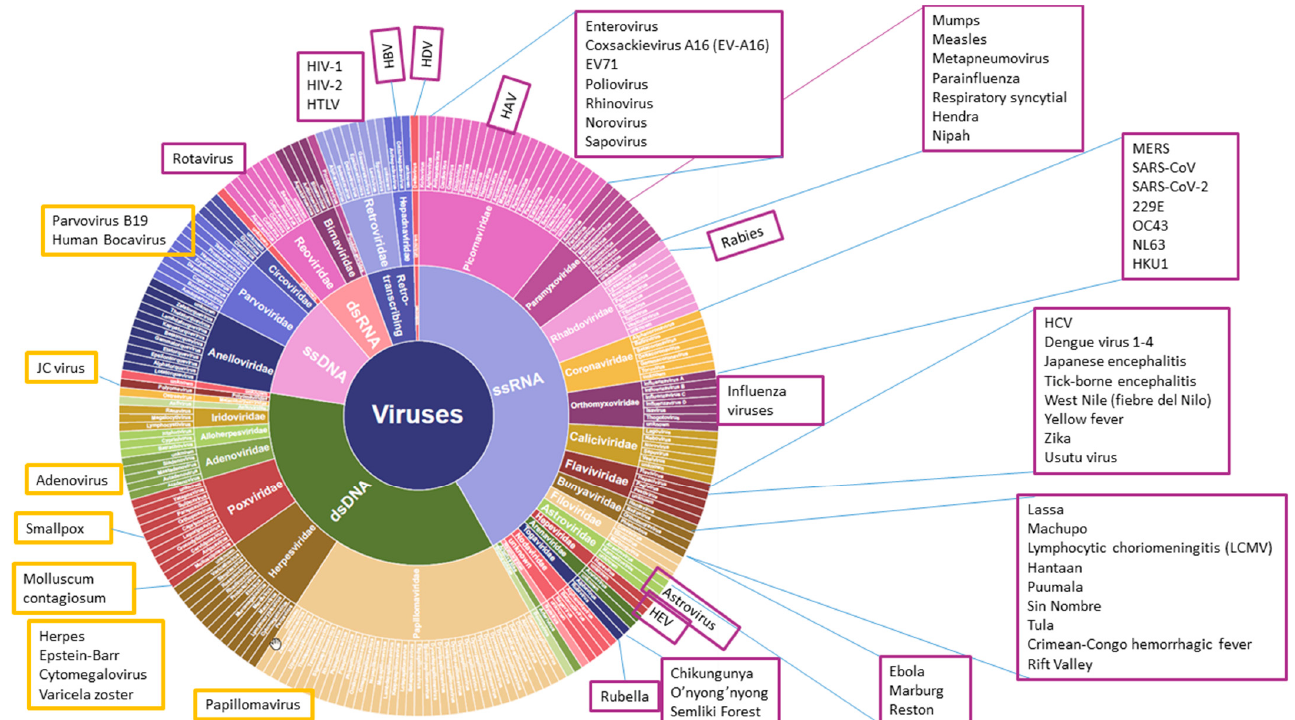
Figure 2. Most human pathogenic viruses in a clock-like classification scheme. Permission kindly provided by Todd N. Wylie; adaptation of Figure 1 of Wylie et al. [52].